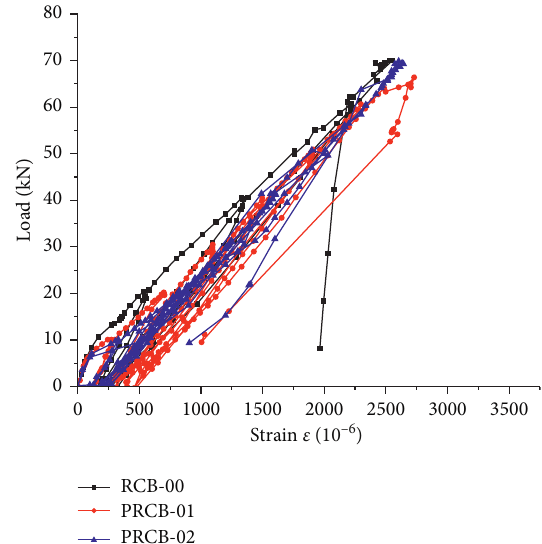
Figure 14: Strain curve of longitudinal reinforcement at position 4 in specimens.